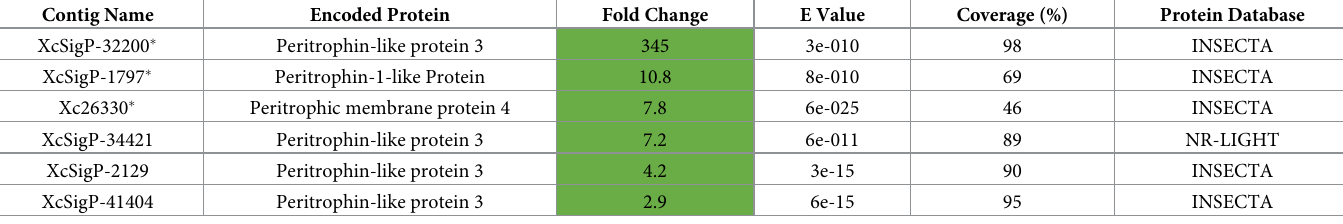
Table 5. Peritrophin transcripts significantly upregulated in response to feeding and infection. Contig